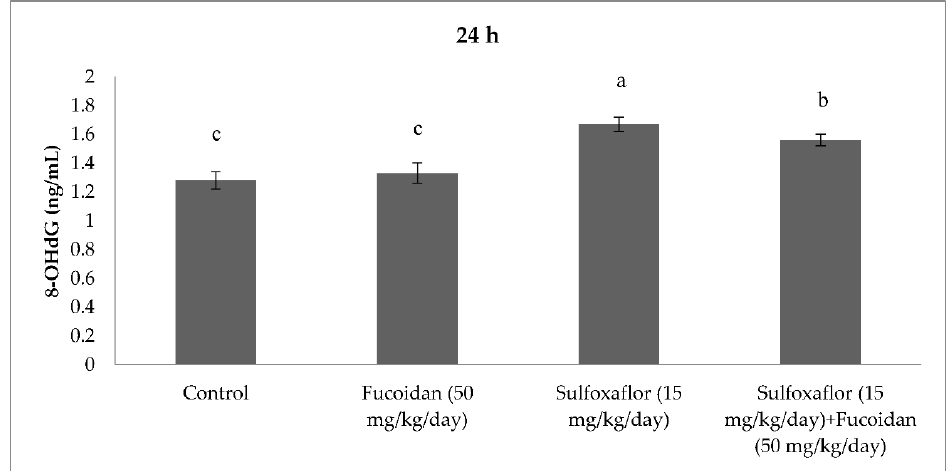
Figure 1. Effects of Sulfoxaflor and Fucoidan on 8-OHdG Levels (ng/mL) in Serum of Mice at 24-h Treatment Periods. Values are expressed as mean±standard error. 8-OHdG: 8-hydroxy-2’-deoxyguanosine. Letters a, b and c show the differences between treatment groups and control. Data shown in different letters are significantly different at p < 0.05 level ( n = 8). Duncan multiple comparison tests were used.